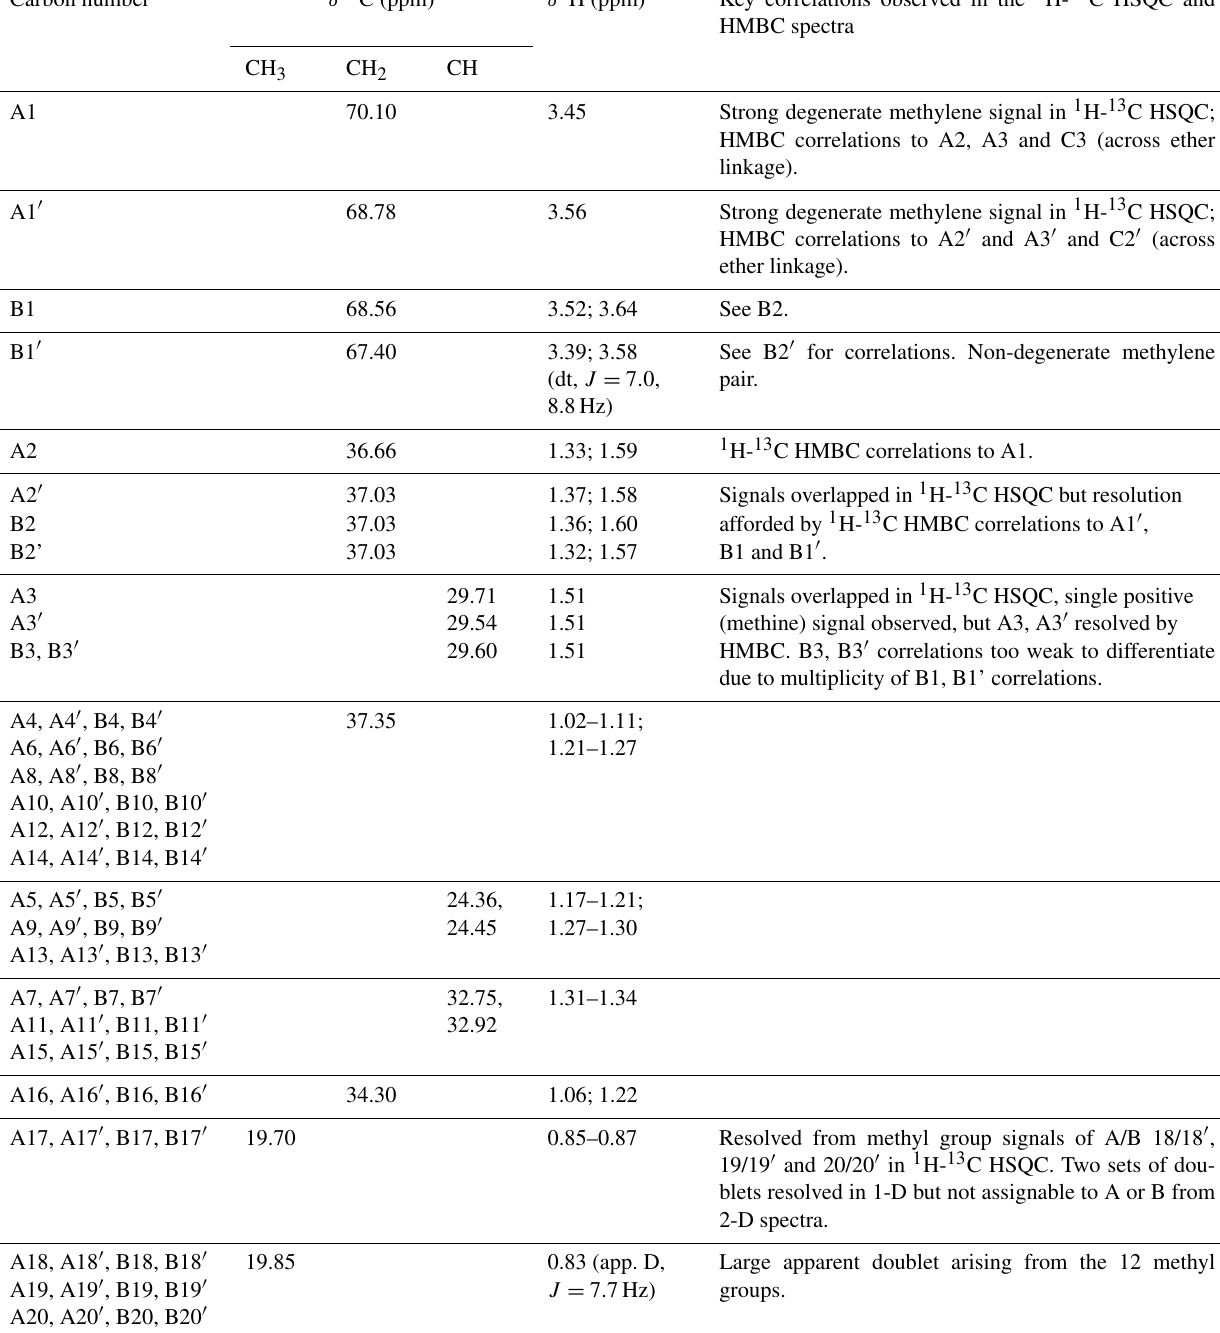
Table 1. 13 C- and 1 H-NMR chemical shifts of BDGT-0 as well as key correlations from 1 H- 13 C HSQC and HMBC spectra. Carbon numbers correspond to the carbon atoms in Fig. 2. Overlapped peaks are given as ranges (i.e., 1.17–1.21ppm). Carbon number Key correlations observed in the 1 H- 13 C HSQC and